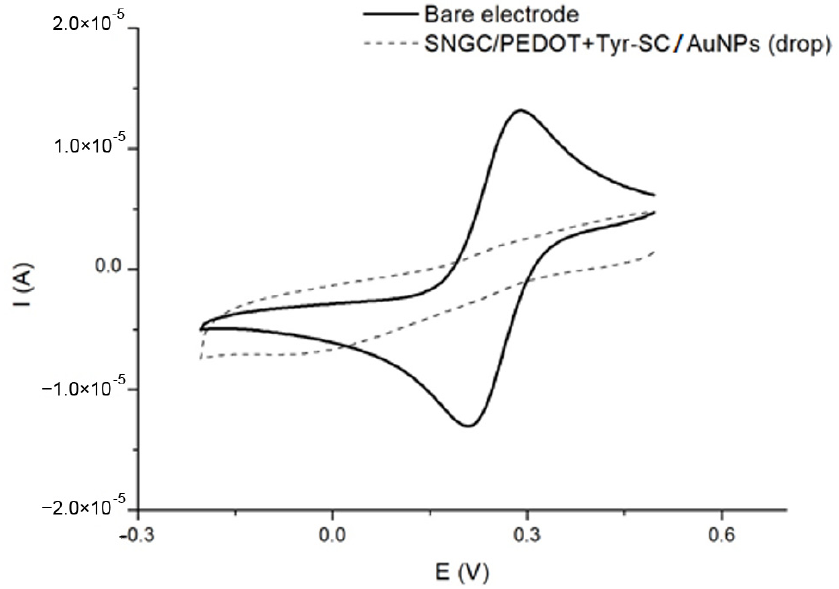
Figure 2. Electrochemical characterization of PEDOT-tyrosinase/Sonogel-Carbon (sinusoidal current-electrodeposited) biosensor modified with drop-casted AuNPs (SNGC/PEDOT+Tyr-SC/AuNPs (drop) (dashed line) and a bare SNGC electrode (bold) in an aqueous solution containing 5 mM K 4 Fe(CN) 6 /K 3 Fe(CN) 6 and 1 M KCl by using CV.